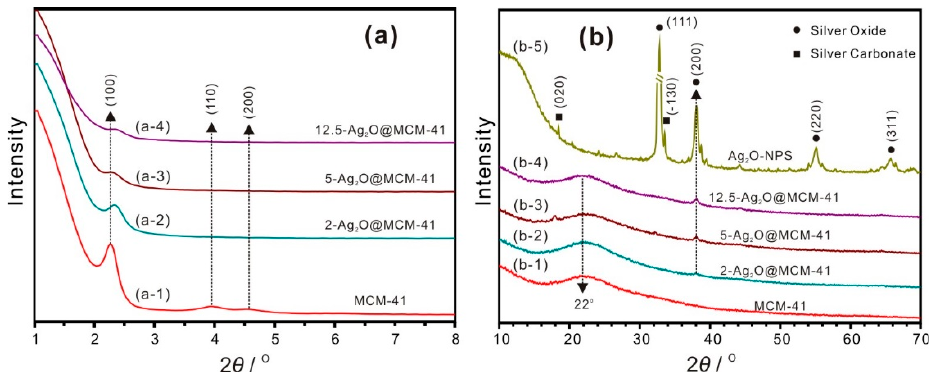
Figure 1. ( a ) small-angle XRD patterns and ( b ) wide-angle XRD patterns of MCM-41, Ag 2 O@MCM-41 nanomaterials with different loading concentrations, and Ag 2 O nanoparticles.